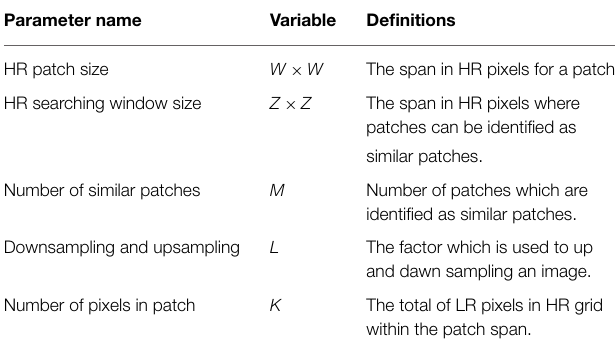
TABLE 1 | CAWF parameters